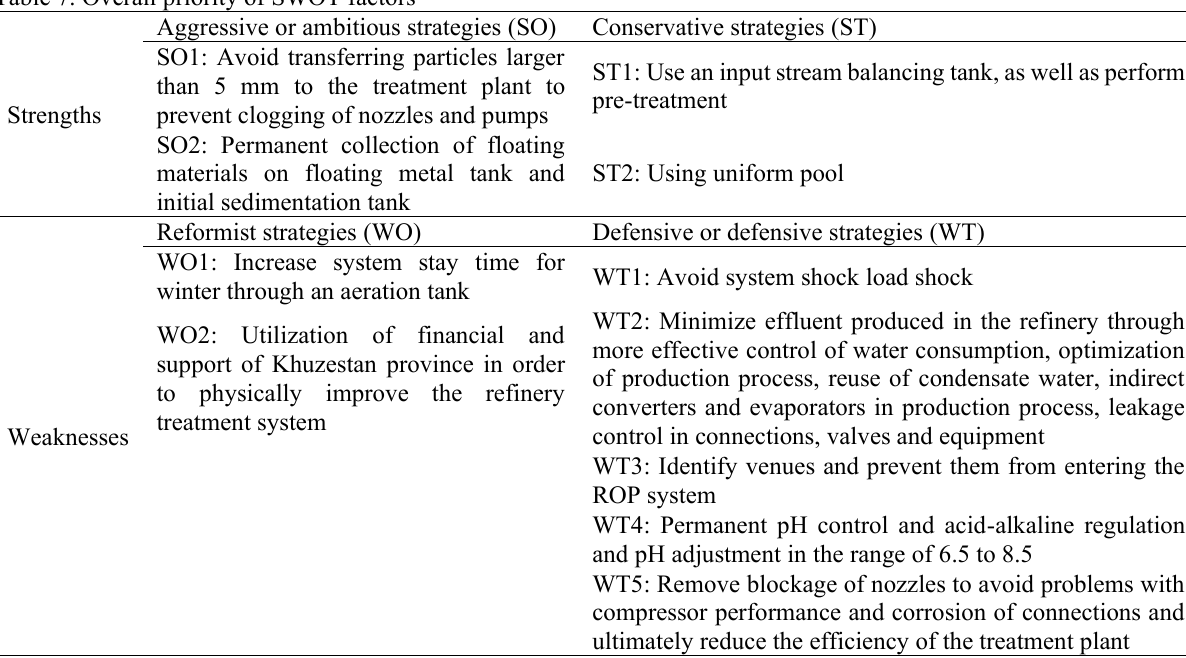
Table 7. Overall priority of SWOT